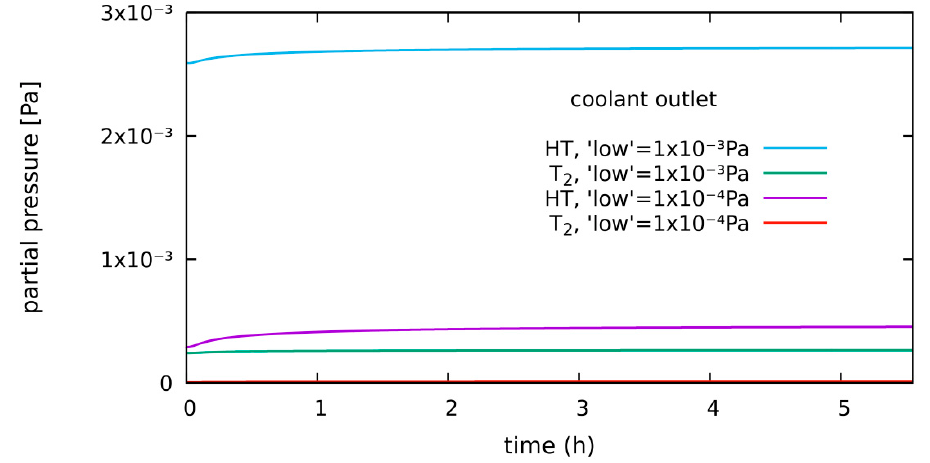
Figure 10. Transient T 2 and HT partial pressure at coolant outlet for 300 Pa H 2 in purge gas for 1 × 10 − 4 Pa vs. 1 × 10 − 3 Pa taken as low level in inlet BCs.